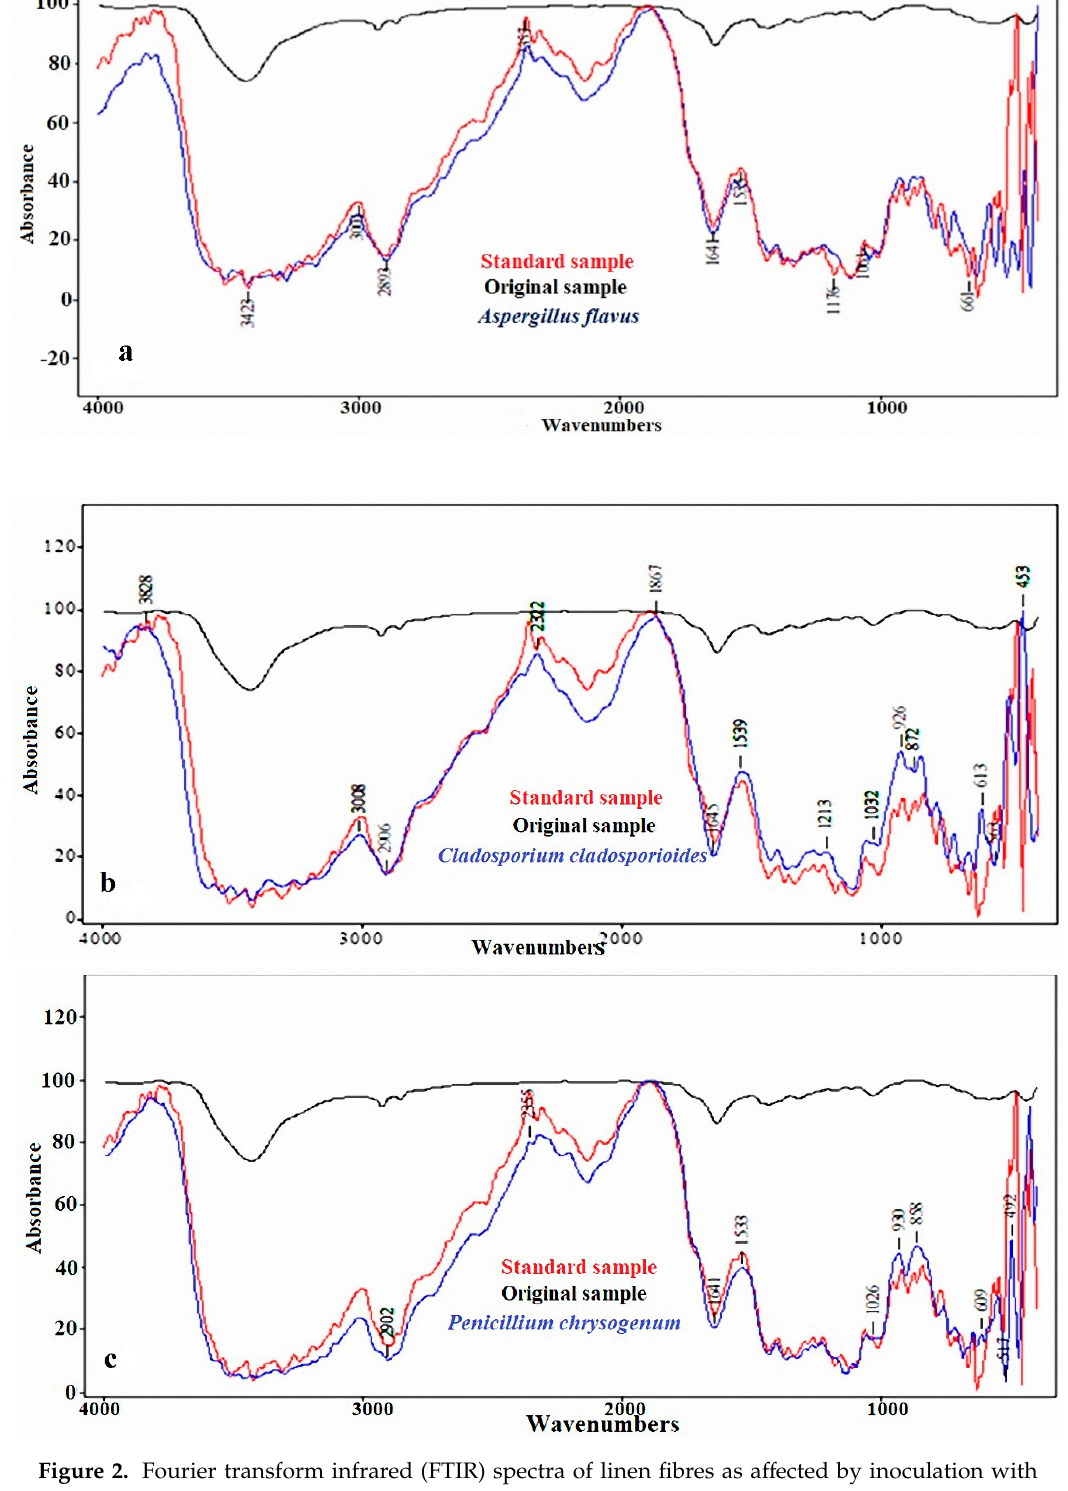
Figure 2. Fourier transform infrared (FTIR) spectra of linen fibres as a ff ected by inoculation with ( a ) Aspergillus flavus , ( b ) Cladosporium cladosporioides , and ( c ) Penicillium chrysogenum .